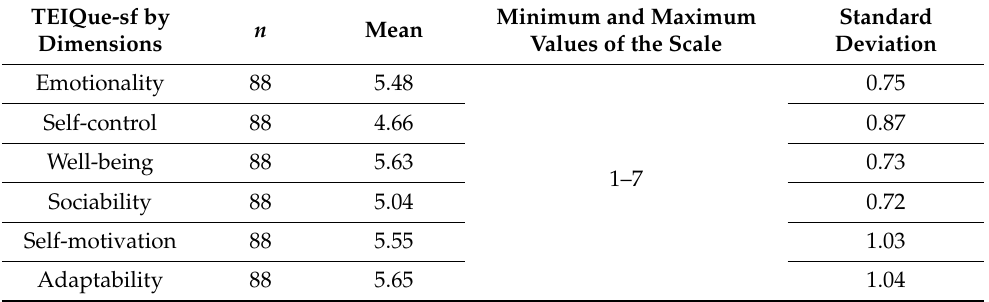
Table A2. Mean and standard deviations of the TEIQue-sf scale by dimension. Source: own elaboration. TEIQue-sf by